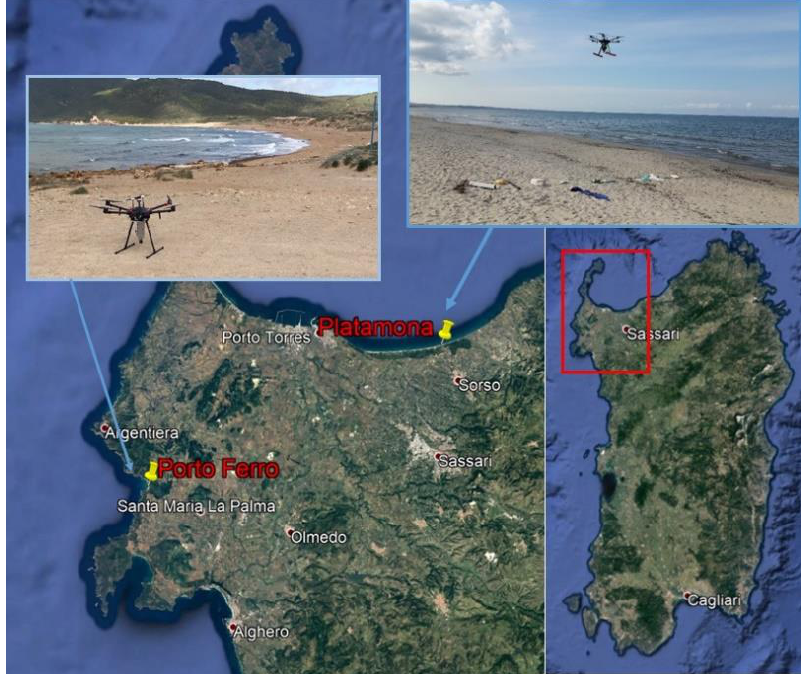
Figure 2. Images of the inspected sites for the field campaigns. Satellite and ground-based photo- graphs of Platamona and Porto Ferro, Sardinia, Italy.